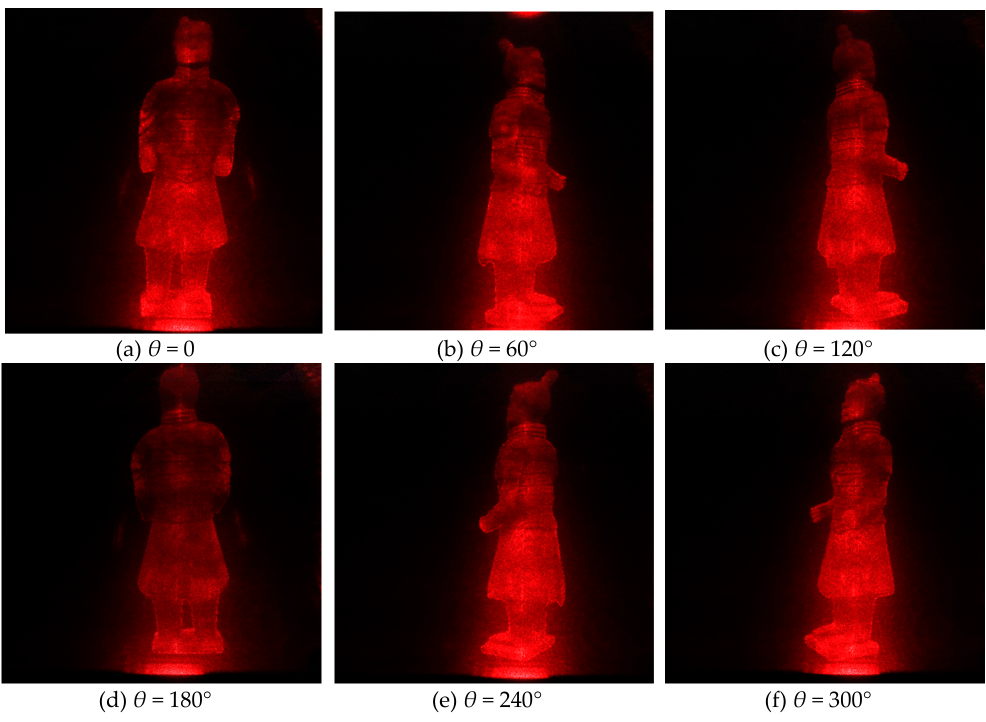
Figure 12. Electro-optical reconstructed images at different viewing angles with kinoform sequence scheme II.